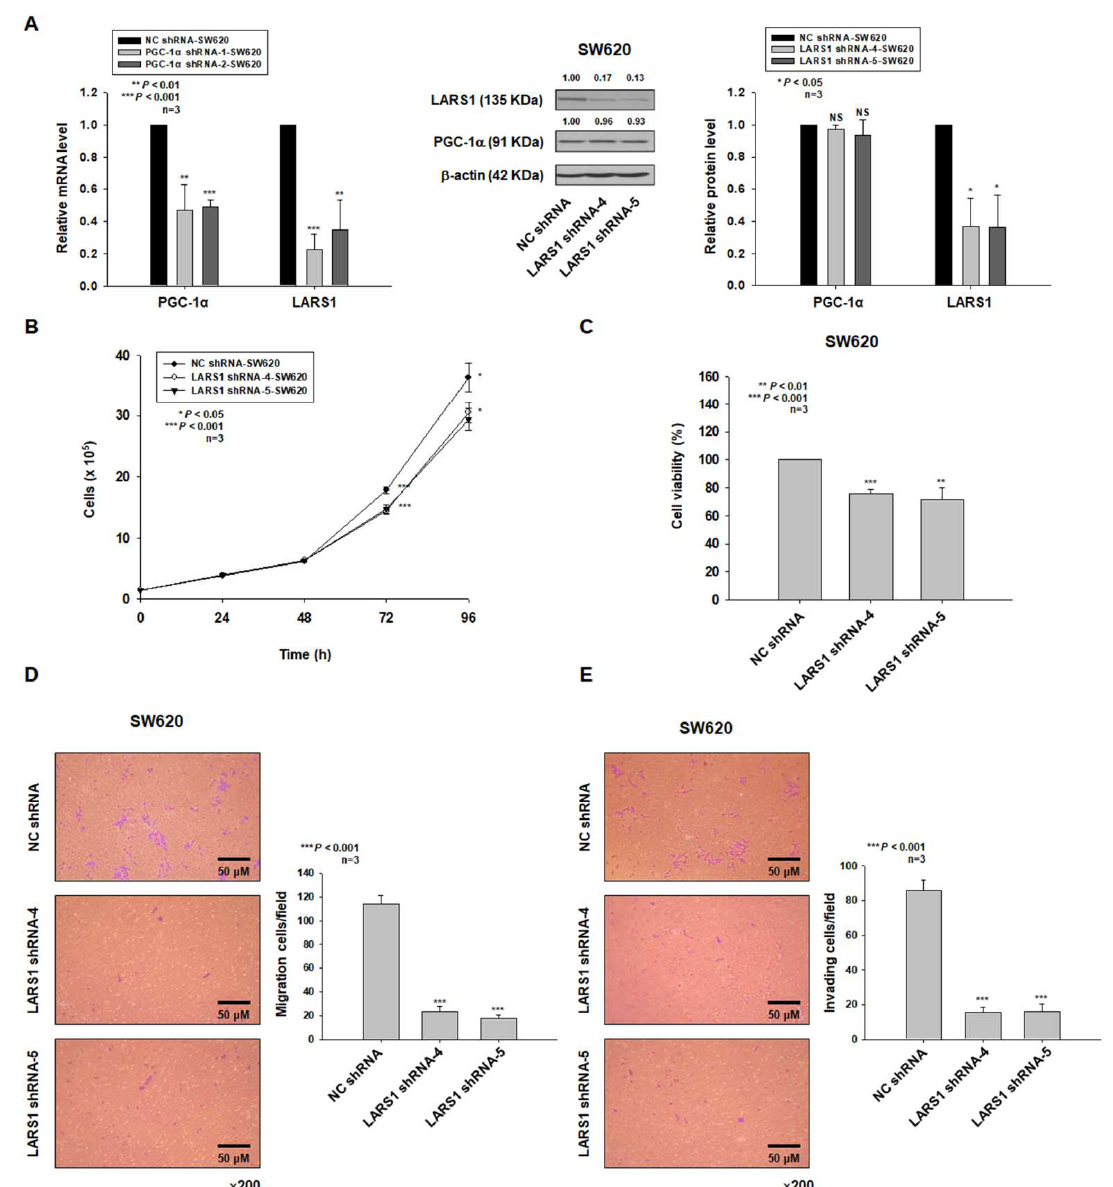
( D ) and transmembrane invaded cells ( E ) were counted for five randomly chosen visual fields. Data are expressed as the mean ± SD of three independent experiments. *** p < 0.001 vs. pCMV6-SW480 cells. Molecular weights for proteins are indicated in the full, uncropped, annotated Western blot images (Figure S4).